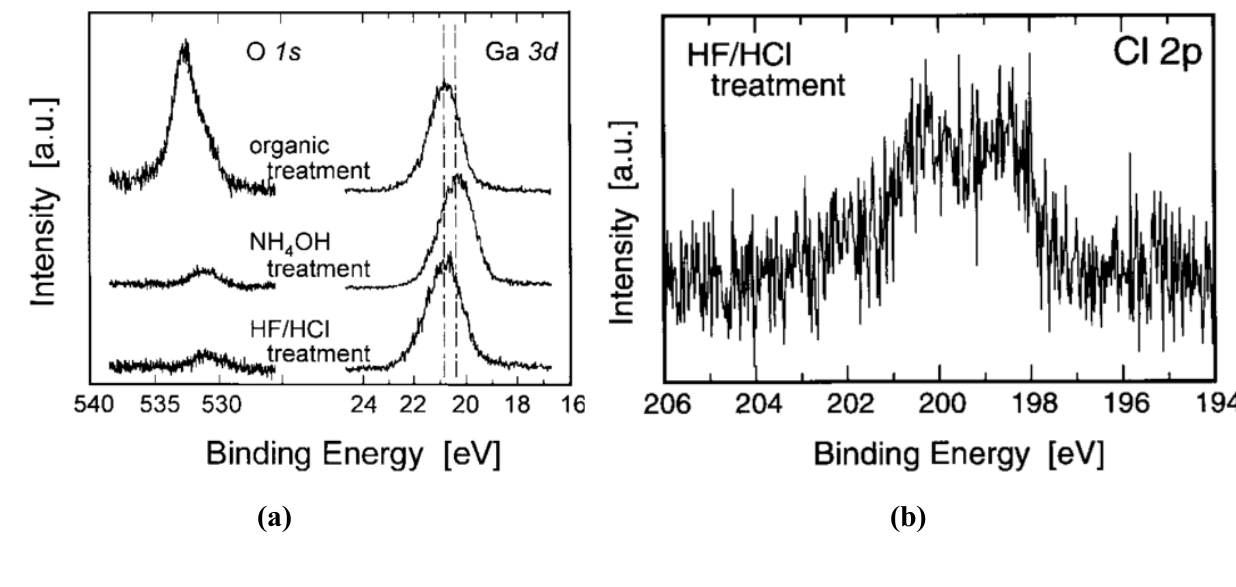
Figure 6. X-ray photoelectron spectroscopy (XPS) spectra of GaN surface